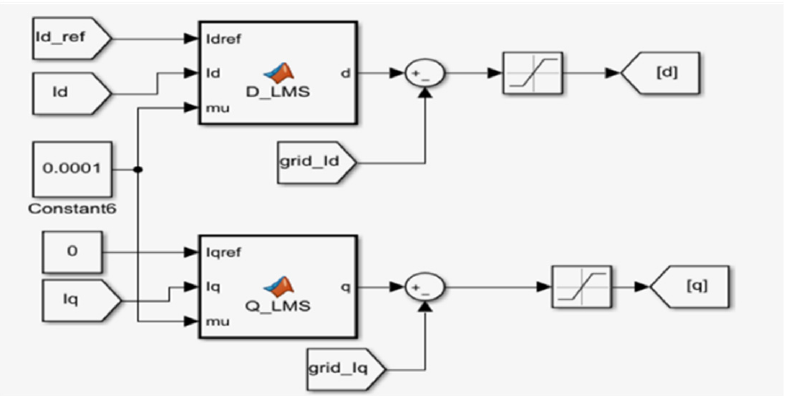
Figure 7. Implementation of an adaptive LMS control law.